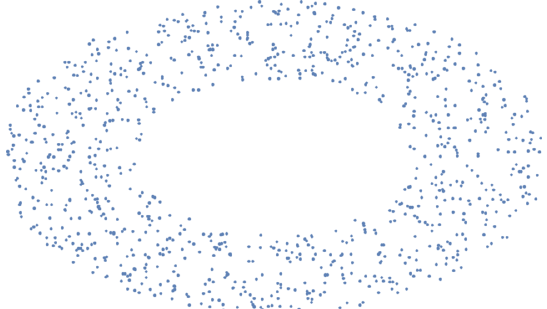
Figure 1 . A point cloud generated by uniformly sampling points from an annulus. Persistent homology formalizes the presence of the hole in the middle.